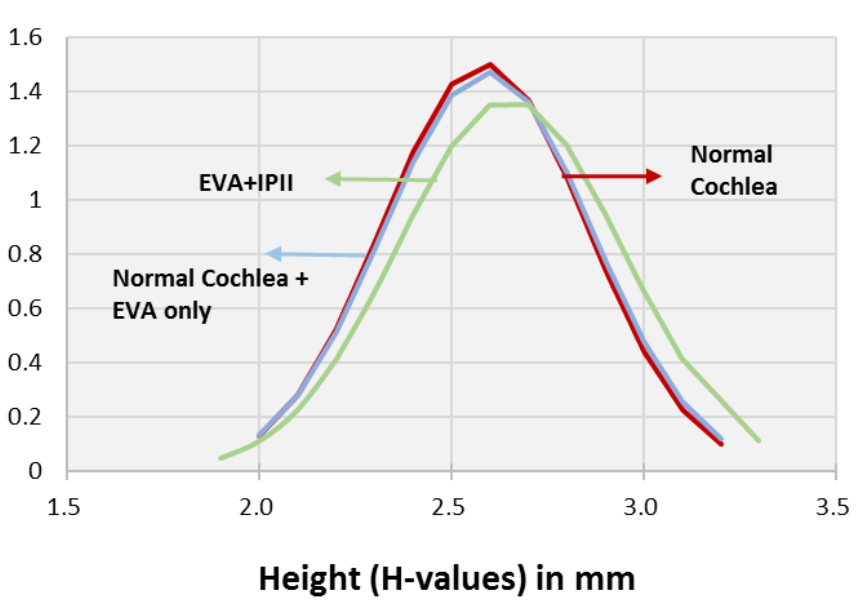
Figure 4. Bell curve (normal distribution curve) of the H value comparing the groups with normal cochleae, normal cochleae + EVA only, and EVA + IP II.